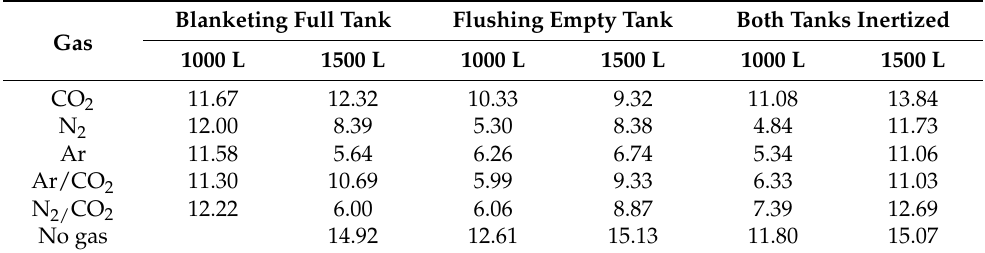
Table 6. Increase in the oxygen partial pressure (hPa) in the model wine during a racking in 1000 L and 1500 L tanks, with different inertization strategies and with different inert